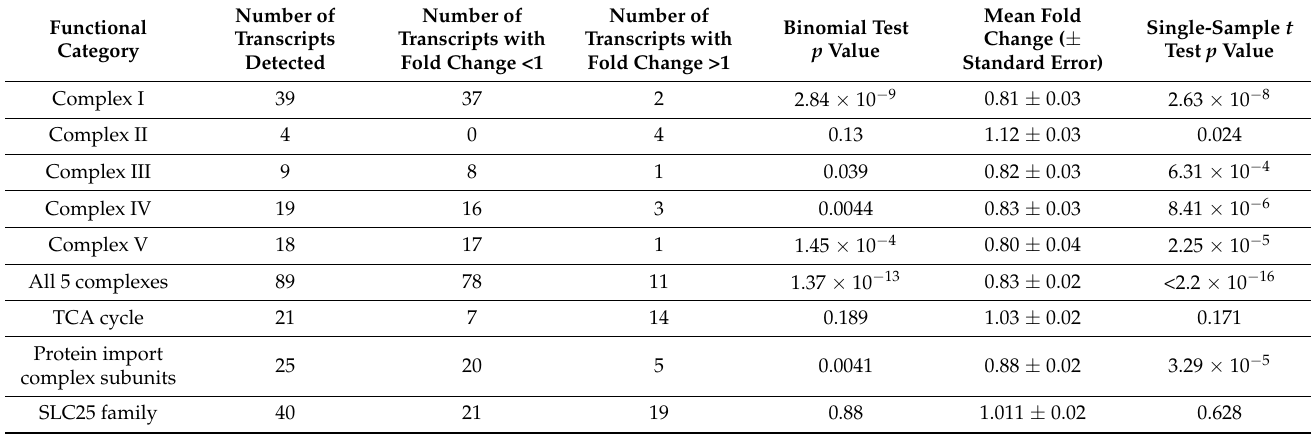
Table 3. Expression of transcripts encoding subunits of the translocase of the inner mitochondrial membrane (TIMM), translocase of the outer membrane (TOMM) and sorting and assembly machinery (SAMM) mitochondrial protein import complexes as well as that oxidative phosphorylaton complexes I, III, IV, and V was reduced in lymphoblasts from Myalgic Encephalomyelitis/Chronic Fatigue Syndrome (ME/CFS) patients ( n = 23) compared to healthy controls ( n = 17). Conversely, expression of Complex II transcripts was elevated, while the expression of transcripts encoding TCA cycle enzymes and SLC25 family transporters were unchanged. Each cell line was sampled once in an RNA sequencing transcriptomics experiment. Mean fold change was calculated for the ME/CFS group versus the control average for each transcript. Binomial tests were employed to assess the fraction differentially expressed with H o set to 0.5. Single-sample t tests were employed to assess magnitude of differential expression with H o being mean fold change =